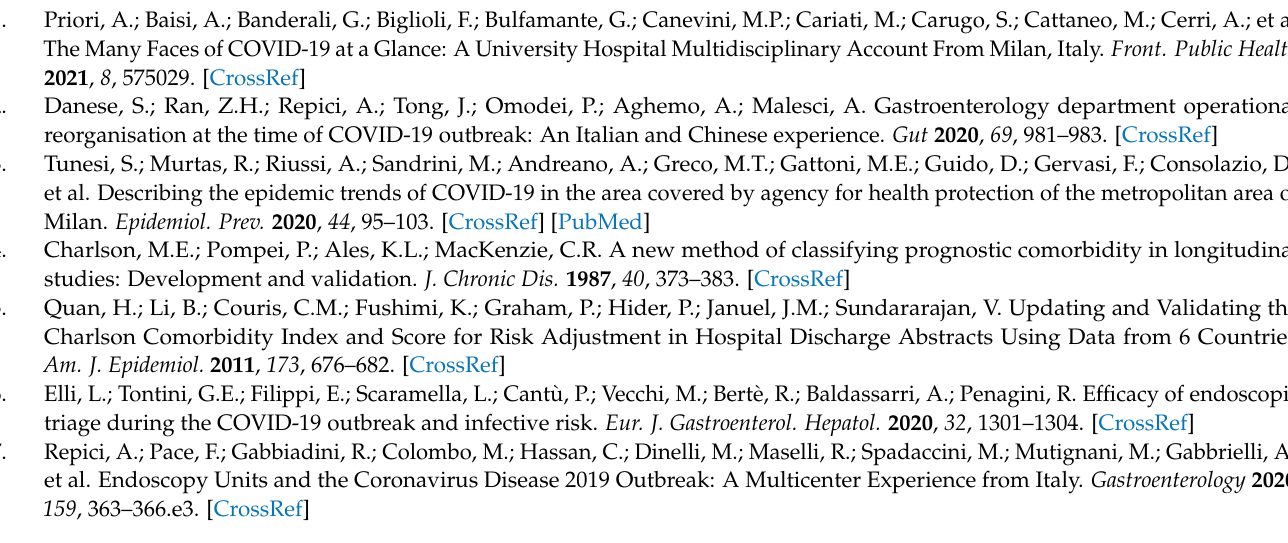
logical Unit. Figure S3: Age at the admission. Figure S4: Gender distribution. Figure S5: Charlson comorbidity index. Figure S6: Mortality. Figure S7: Patients attending at least one diagnostic proce- dure. Figure S8: Days from admission to diagnosis of SARS-CoV-2 infection. Figure S9: Days from the admission in the Gastroenterological Unit to the diagnosis of COVID-19 shown for each case. Table S1: Discharge diagnoses of deceased patients. Table S2: Days from the admission to the Unit to the diagnosis of COVID-19 during the first